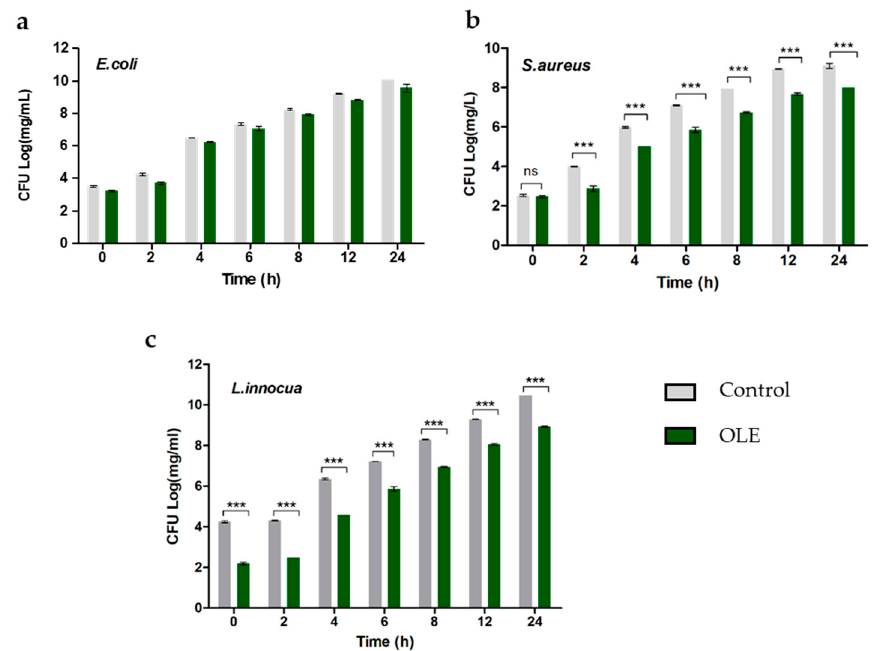
Figure 1. Bar graphs showing the effect of OLE administration at 100 mg/mL total polyphenols (TPs) on the growth of different bacterial strains: ( a ) E. coli , ( b ) S. aureus , ( c ) L. innocua , up to 24 h. The values are reported as mean ± standard error of the mean (SEM) (n = 3), significance at p < 0.05 by One-way ANOVA and Tukey ′ s HSD post hoc test; *** p < 0.0001, n.s. not significant. For E. coli , OLE did not exhibit any significant antimicrobial effect (Figure 1a). Con- versely, in S. aureus and L. innocua statistically significant antimicrobial effects were ob- served over time (Figure 1b,c). In particular, for L. innocua OLE showed a reduction in the number of colonies even if inactivation was not reached (Figure